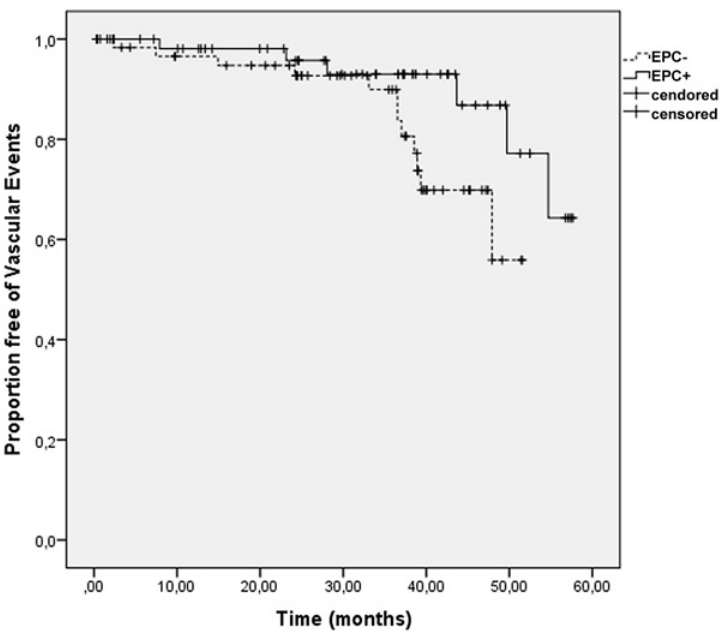
Fig 2. Kaplan-Meier Survival Curves for Vascular Events in Patients with (EPC+) and Without (EPC-) Circulating EPC. Result of the Log-rank test Comparing Both Groups, p = 0.058.